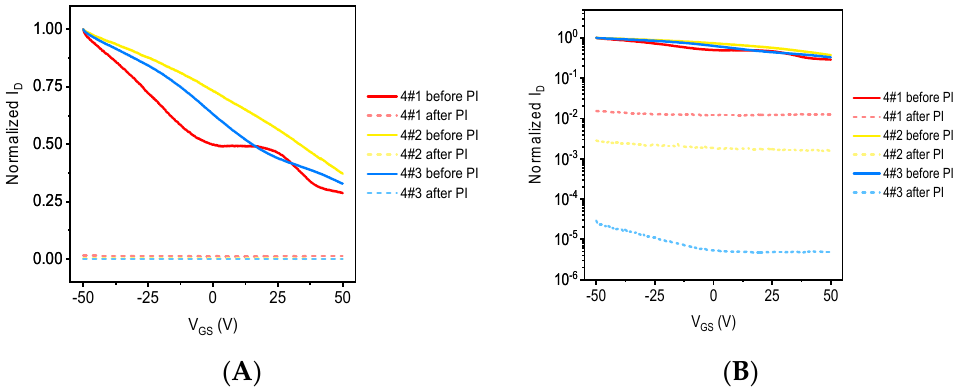
Figure 11. The transfer characteristic curve of graphene samples before and after proton irradiation. ( A ) Linear coordinates and ( B ) logarithmic coordinates.